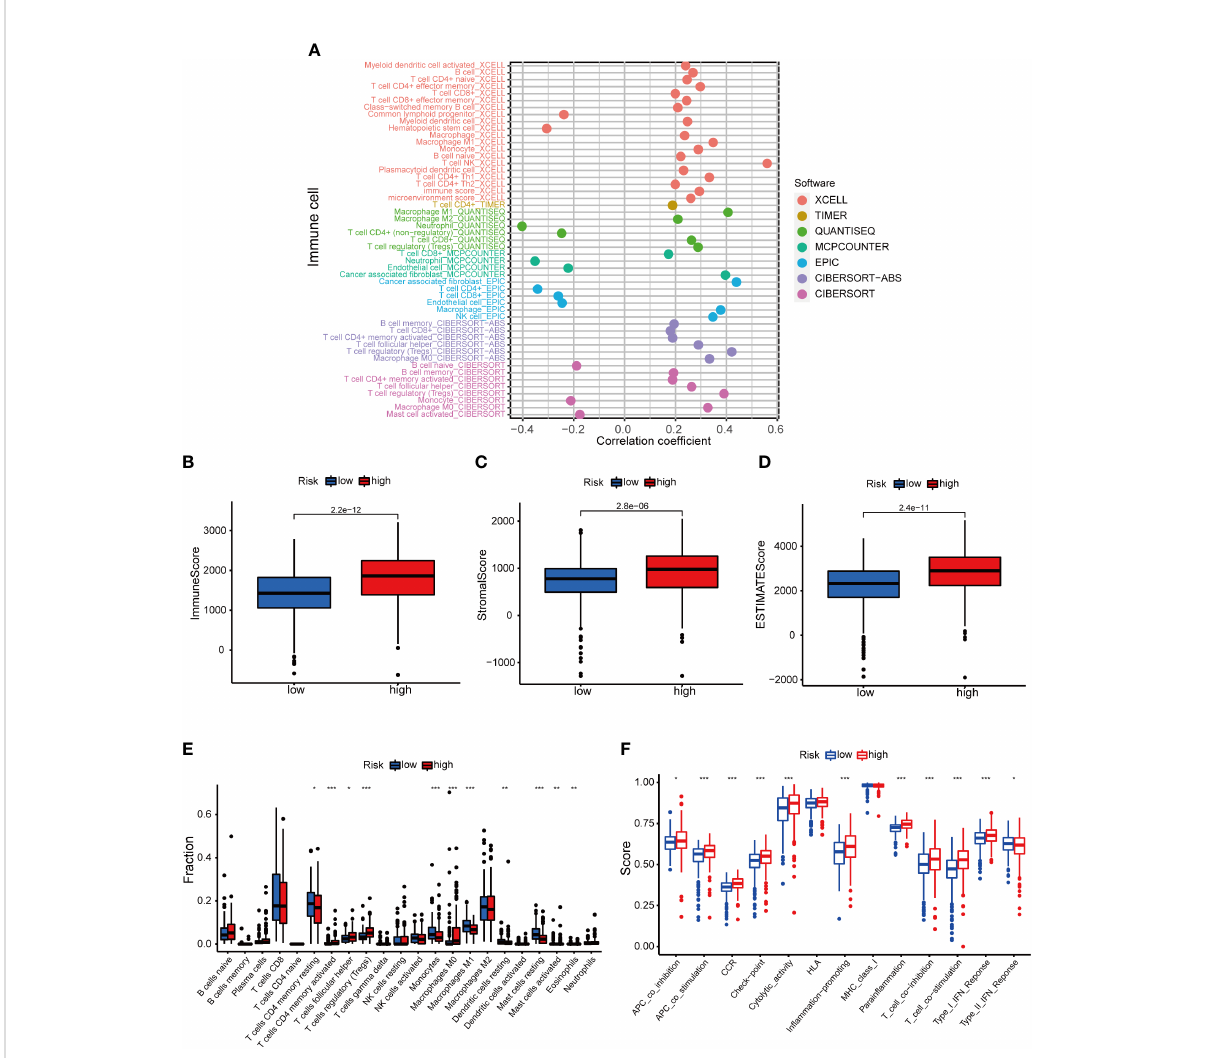
FIGURE 7 The role of basement membrane model in the immunotherapy. (A) The immune cell bubble of risk groups. (B – D) . Immune-related scores in LRS and HRS groups. (E, F) . The relative proportions of immune cells and immunological activities were assessed using ssGSEA in the HRS and LRS groups. * p < 0.05, ** p < 0.01, and *** p <